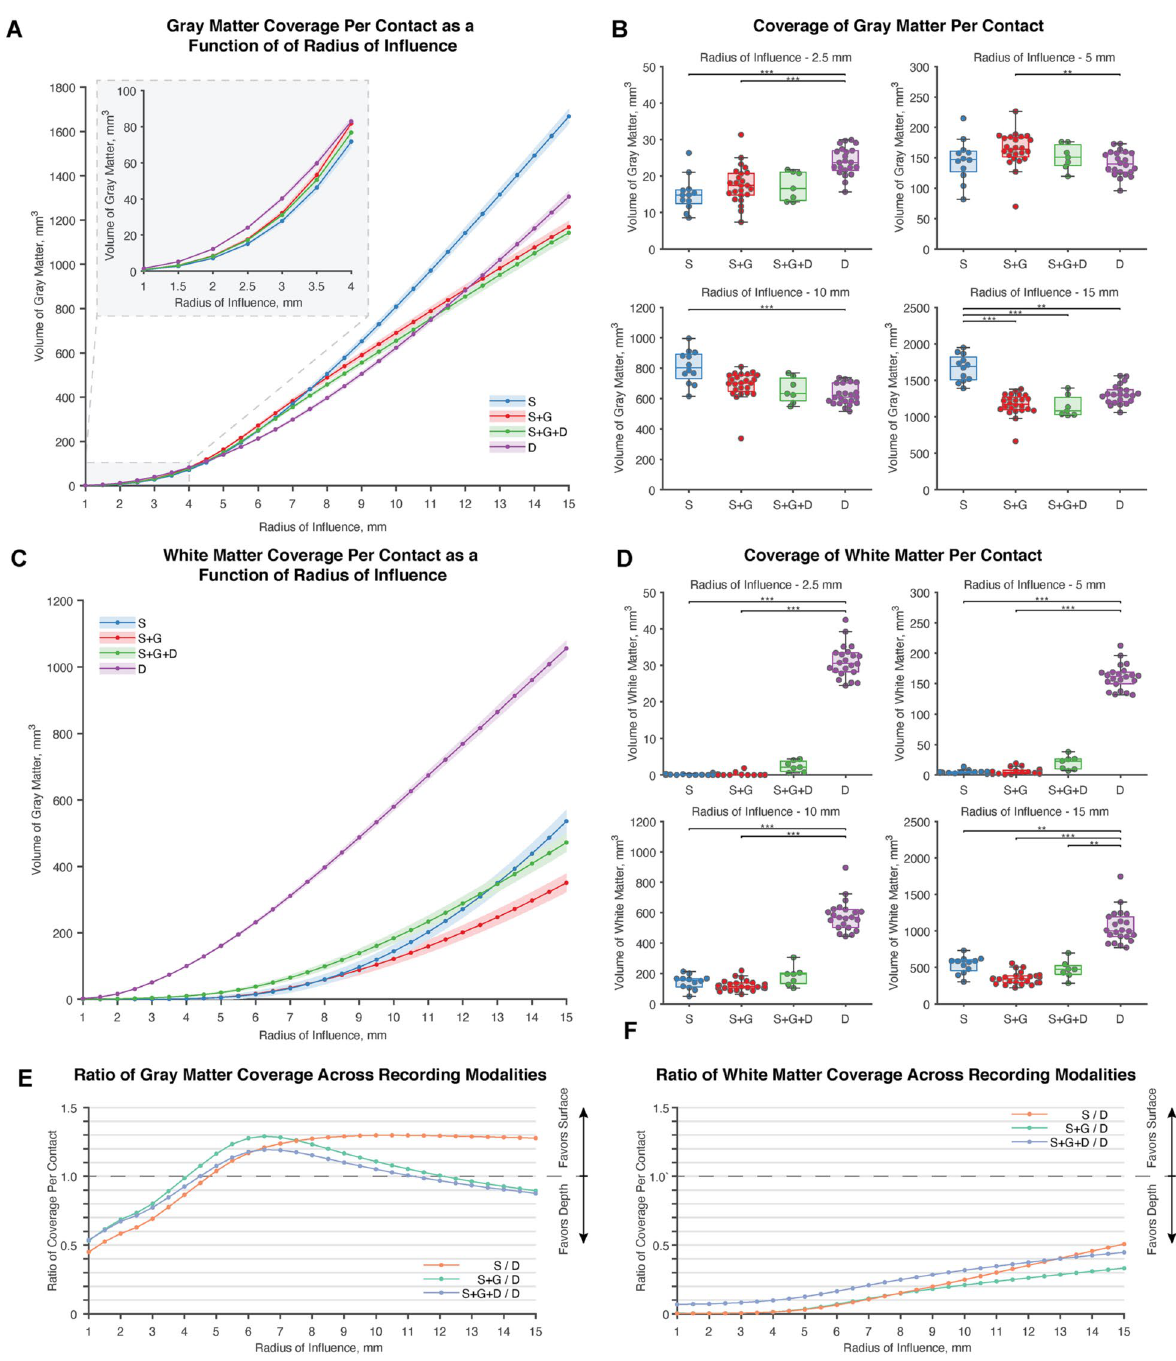
Figure 2. Gray and white matter coverage per contact across RoIs. ( A ) There was a dynamic relationship between gray matter coverage and the size of the RoI used across intracranial modalities. ( B ) Across notable RoIs at 2.5 mm, 5 mm, 10 mm, and 15 mm, depth electrodes covered more gray matter at small RoIs than strip electrode or strip and grid electrode combinations (S & D: p = 3.2 × 10 –5 ; S + G & D: p = 5.34 × 10 –5 ); however, the relationship reversed for strip + grid and depth electrodes at a 5 mm RoI (S + G & D: p = 0.00326) and reversed for strip and depth electrodes at a 10 mm RoI (S & D: p = 1.86 × 10 –5 ). At 15 mm, strip electrodes exceeded other intracranial electrode approaches in gray matter coverage on a per contact basis (S & S + G: p = 5.17 × 10 –7 ; S & S + G + D: p = 3.60 × 10 –5 ; S & D: p = 0.00477). ( C ) White matter coverage varied across recording modalities, but was dominated by depth electrodes. Though not significant, cases that used strip, grid, and depth electrodes in combination appeared to increase